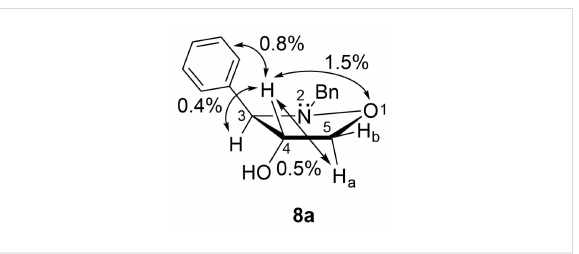
Figure 2: Selected NOE enhancements observed in the isoxazolidin-4- ol trans - 8a . The arrows show the NOESY